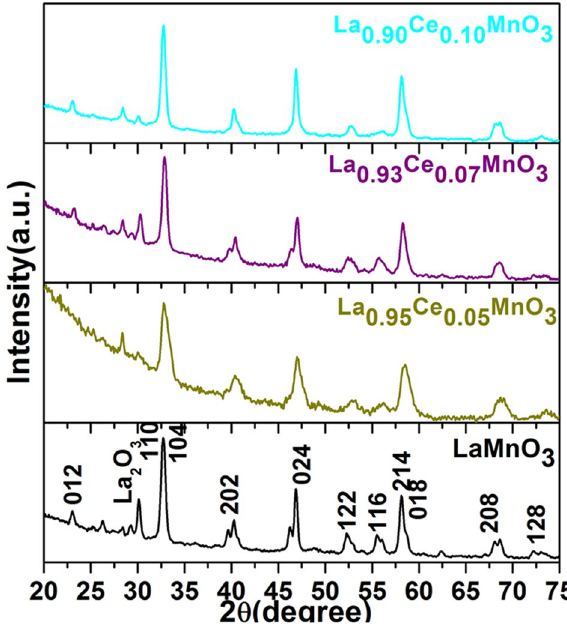
Figure 1. X-ray diffraction pattern of LaMnO 3 , La 0.95 Ce 0.05 MnO 3 , La 0.93 Ce 0.07 MnO 3 and La 0.90 Ce 0.10 MnO 3